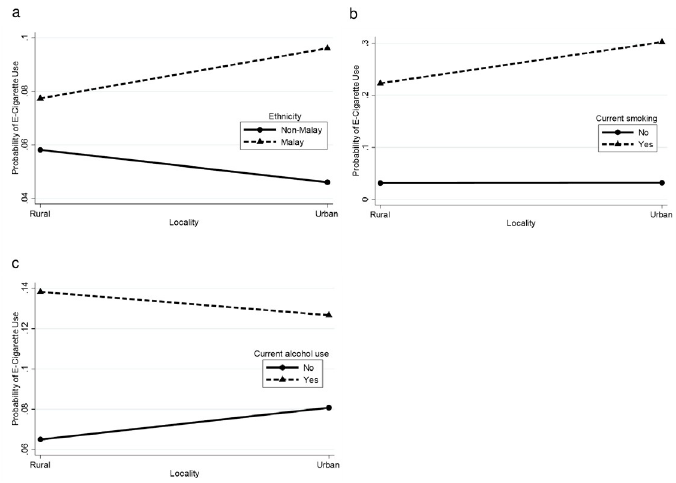
Fig 4. Probability of current e-cigarette use. (a) Locality-ethnicity: rural (non-Malay = 5.8%, Malay = 7.7%), urban (non-Malay = 4.6%, Malay = 9.6%). (b) Locality-smoker: rural (no = 3.2%, yes = 22.3%), urban (no = 3.3%, yes = 30.2%). (c) Locality-current alcohol use: rural (no = 6.5%, yes = 13.8%), urban (no = 8.1%, yes = 12.7%).